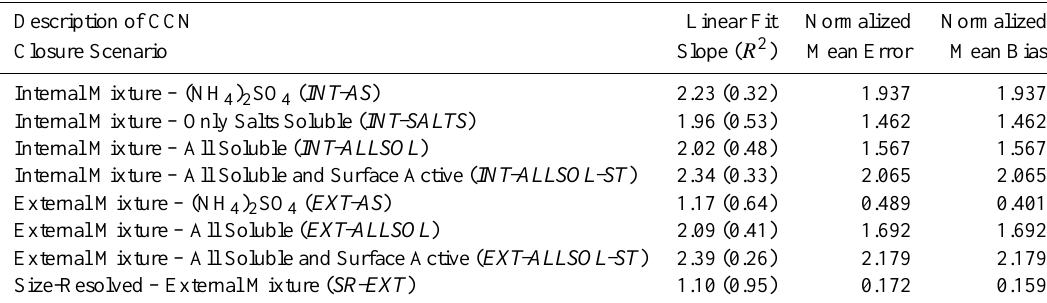
Table 2. CCN closure analysis error metrics for entire AMIGAS campaign. Description of